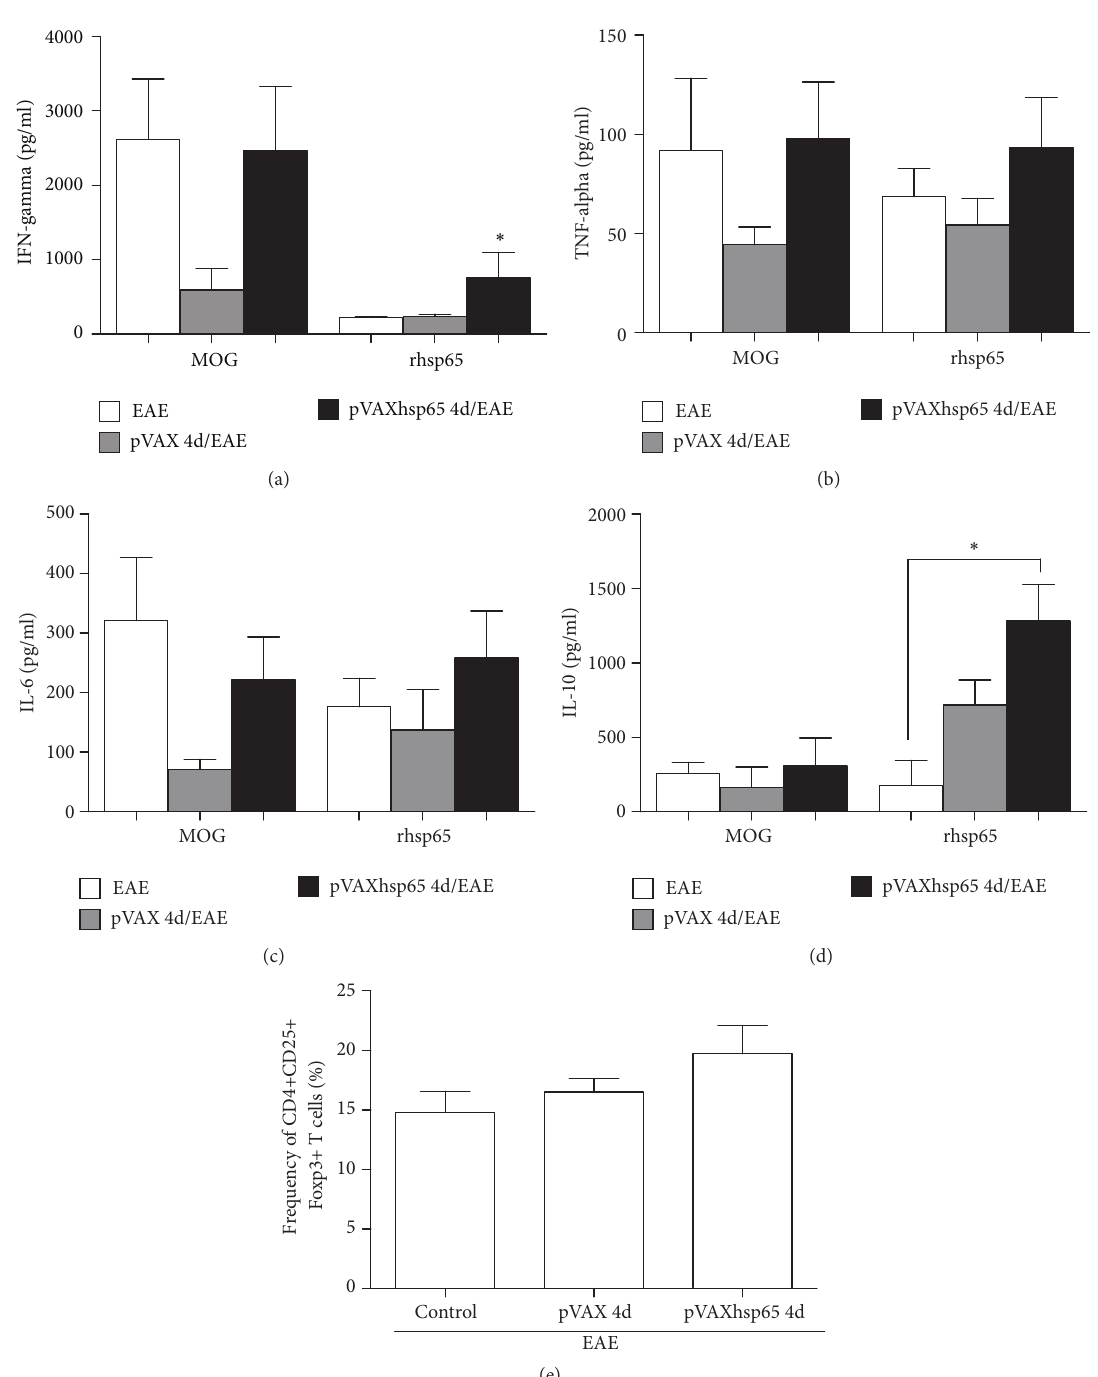
Figure 5: Effect of previous vaccination with pVAXhsp65 at the CNS . C57BL/6 mice were immunized with 4 pVAXhsp65 doses